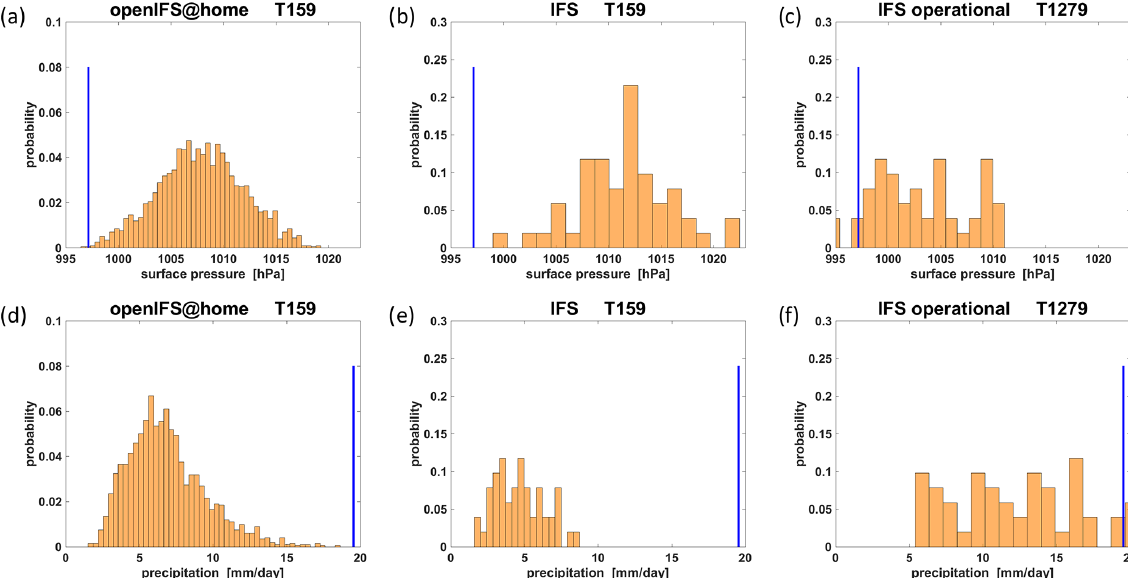
Figure 5. Ensemble forecast distribution near Bergen of mean sea level pressure (a–c) and total precipitation (d–f) in the OpenIFS@home ensemble (a, d) , in the IFS experiment (b, e) , and in the operational forecast (c, f) . The vertical blue line indicates the verification as derived from ECMWF’s analysis. Mean sea-level pressure data are for a 72h forecast lead time. Total precipitation data are accumulated between forecast lead times of 60 and